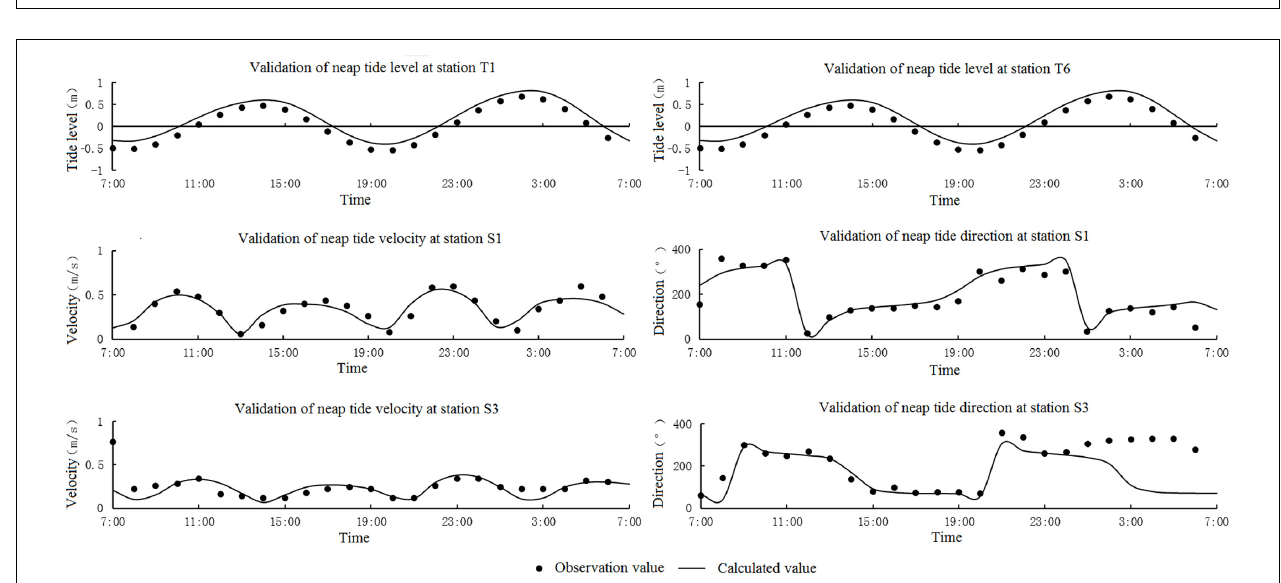
FIGURE 3 | Validation of tide level, current velocity, and direction in Bohai Bay (spring tide).